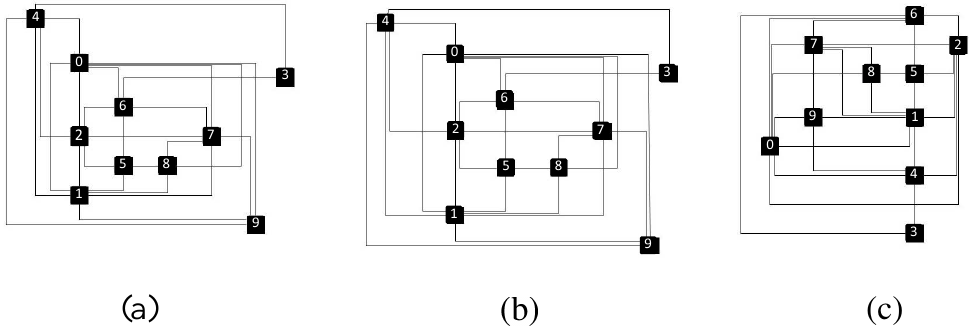
Figure 1. Three orthogonal drawings of the same graph. Drawings ( a , b ) have the same orthogonal representation, while a drawing of a different orthogonal representation is shown in ( c ).